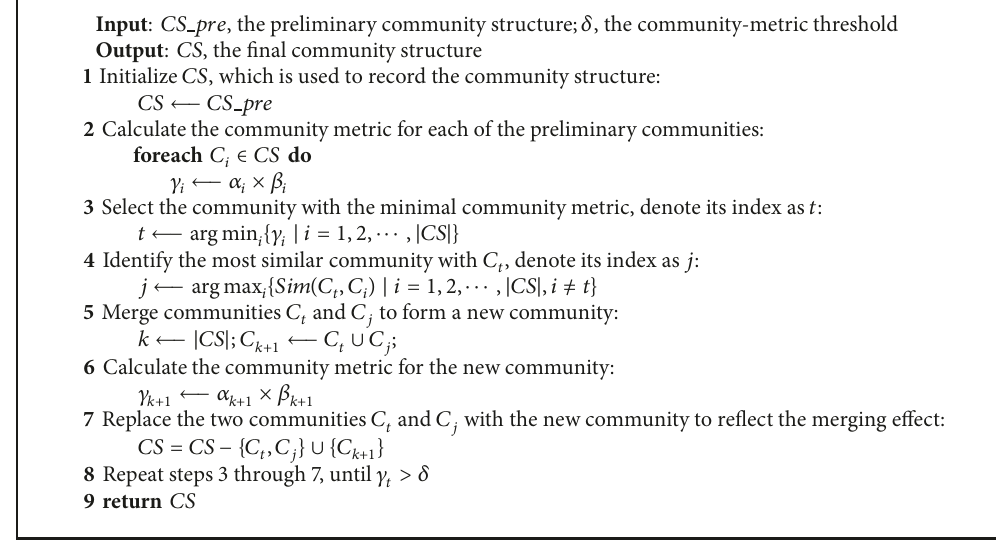
Algorithm 3: PCM ( 𝐶𝑆 𝑝𝑟𝑒 , 𝛿 ): merge small or sparse